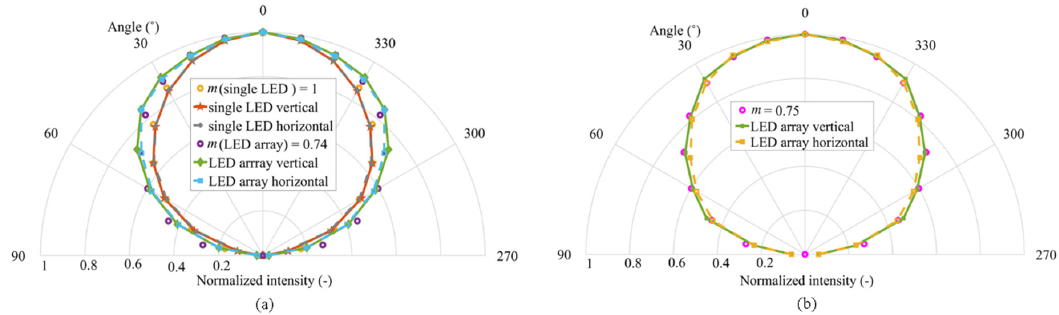
Figure 2. Measured Tx radiation patterns of: ( a ) a single LED in an array and for full LED array; and ( b ) a full LED array with the grid and the diffuser.